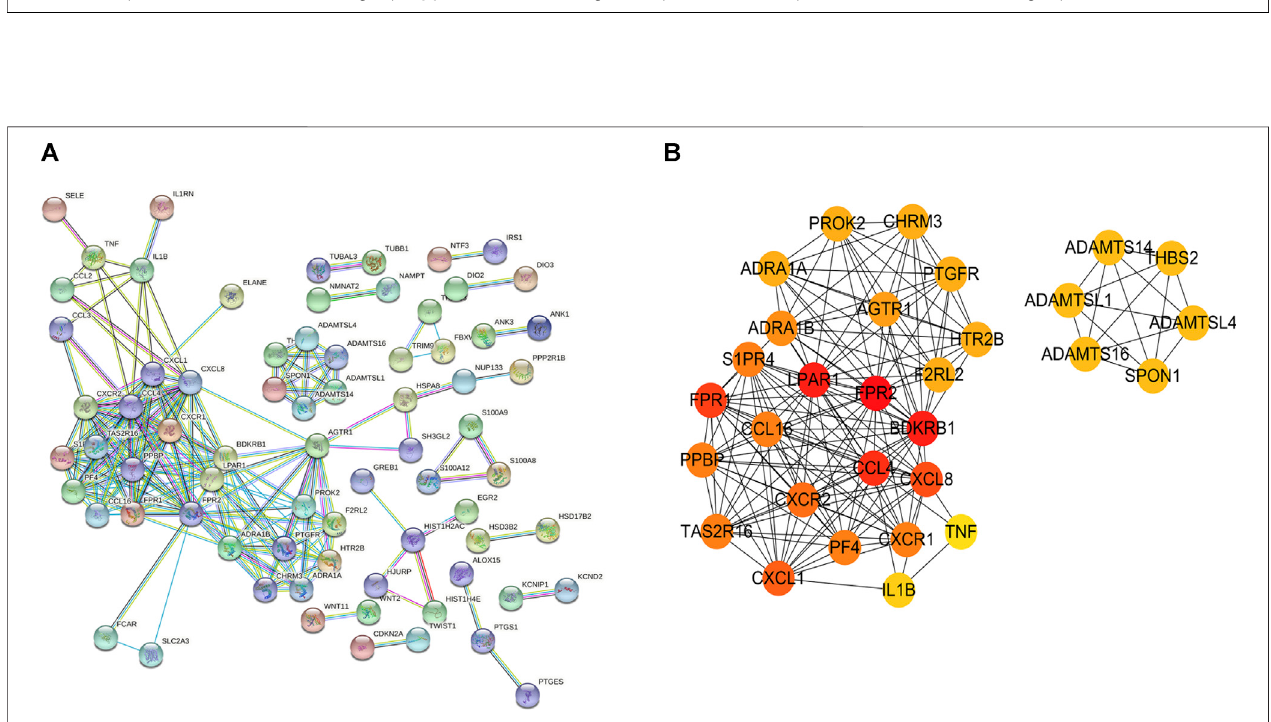
FIGURE 2 | Top 30 hub genes identi fi ed in the PPI networks. (A) PPI network of differentially expressed genes. (B) Top 30 hub genes of differentially expressed mRNAs.